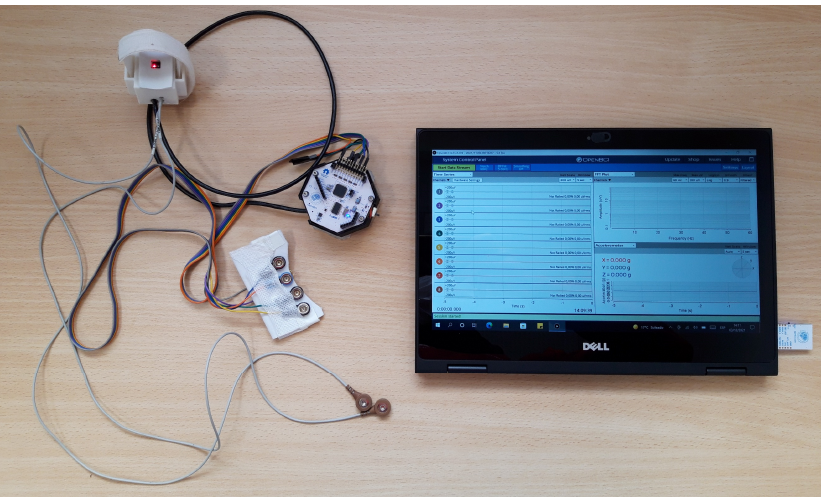
Figure 6. Ambulatory monitoring system with the tablet. As for the final arrangement of the monitoring system on the user, as mentioned above, the PPG sensor was attached to the wrist by a Velcro strap, the two ECG electrodes were placed on both sides of the chest, and the ear EEG array was attached behind the right ear by means